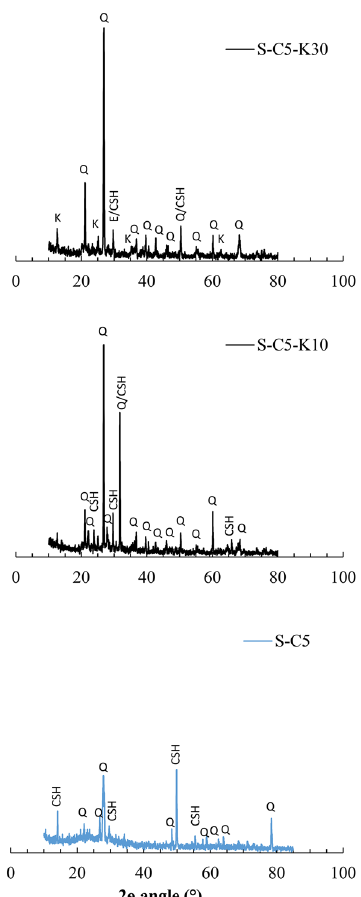
Fig. 22 The XRD graph of mixtures with 5% cement enriched with kaolinite additive (Q: quartz, CSH: calcium silicate hydration, P: portandite, E: ettrinigite, K: